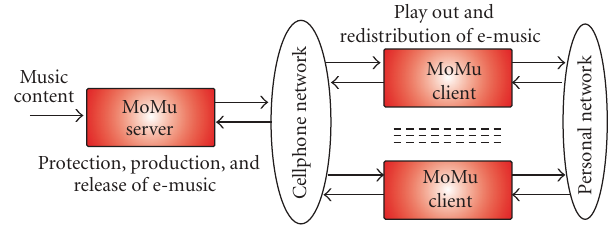
Figure 1: MoMu architecture: the cellphone network distribution is coupled with personal network built upon (free-of-charge) personal wireless communication technologies like Bluetooth and Wi-Fi.